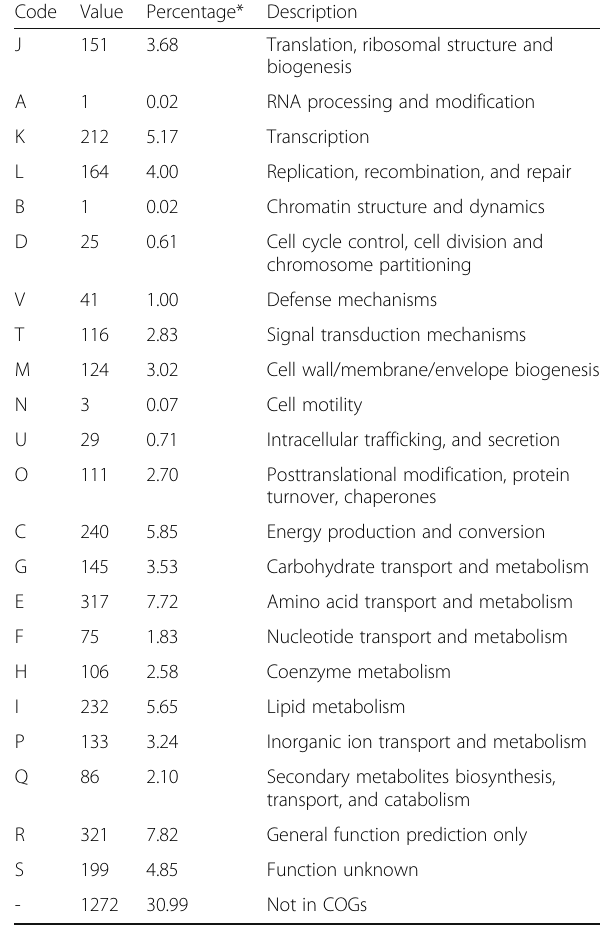
Table 4 Number of protein coding genes of N. dokdonensis FR1436 associated with the general COG functional categories